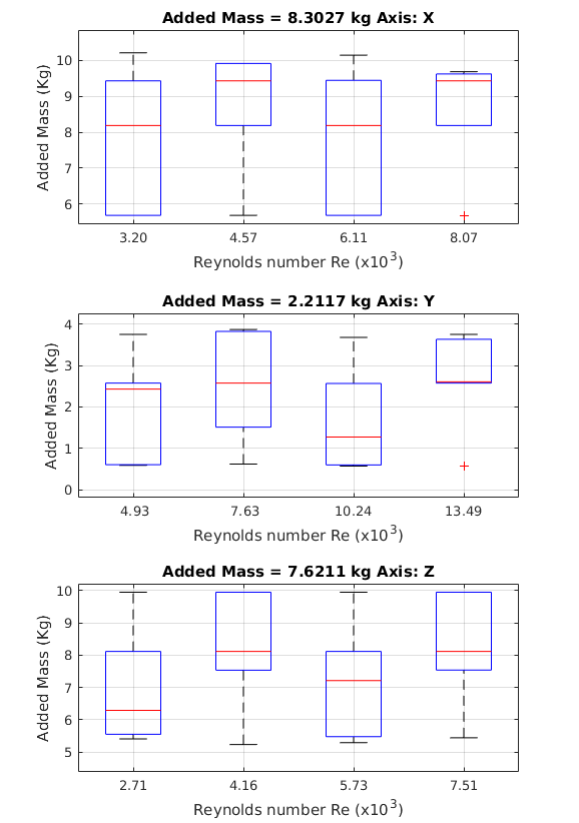
Figure 11. Values obtained for the mass added using the free decay pendulum test. The values of the red crosses are